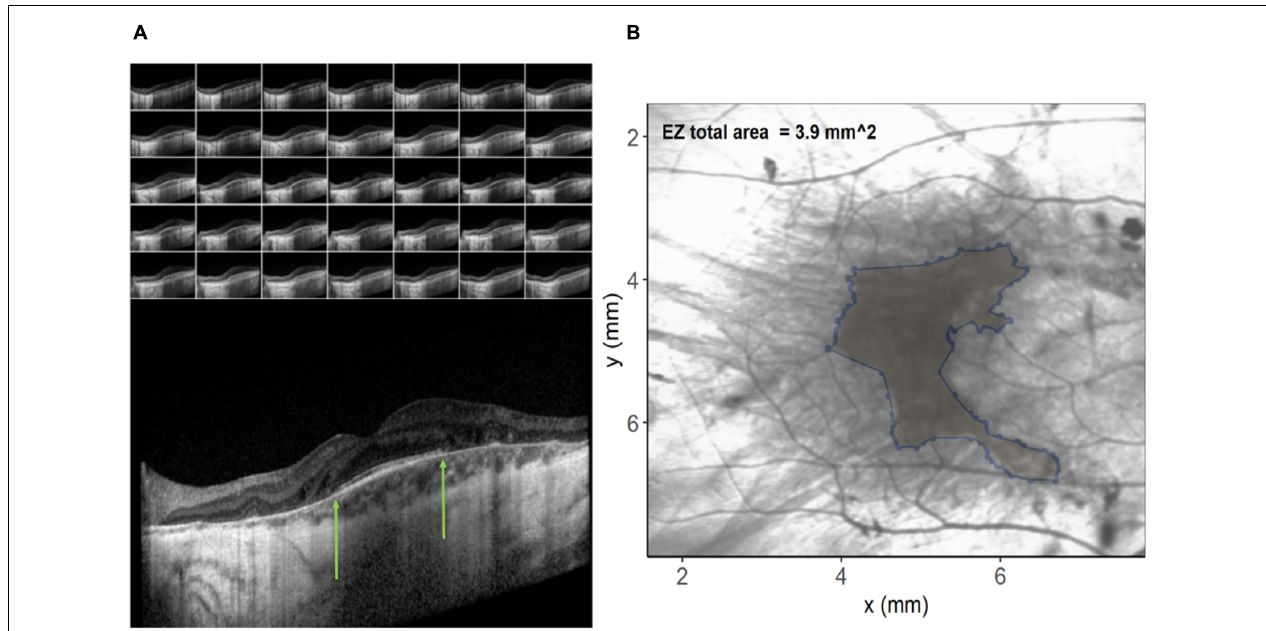
FIGURE 2 | (A) Images on the left show the individual b-scan slices from an optical coherence tomography (OCT) volume with the central slice expanded. The green arrows denote the edges of the ellipsoid zone. These co-ordinates from each of the slices are plotted on the infra-red image on the right (B) and connected to create an ellipsoid area across the OCT